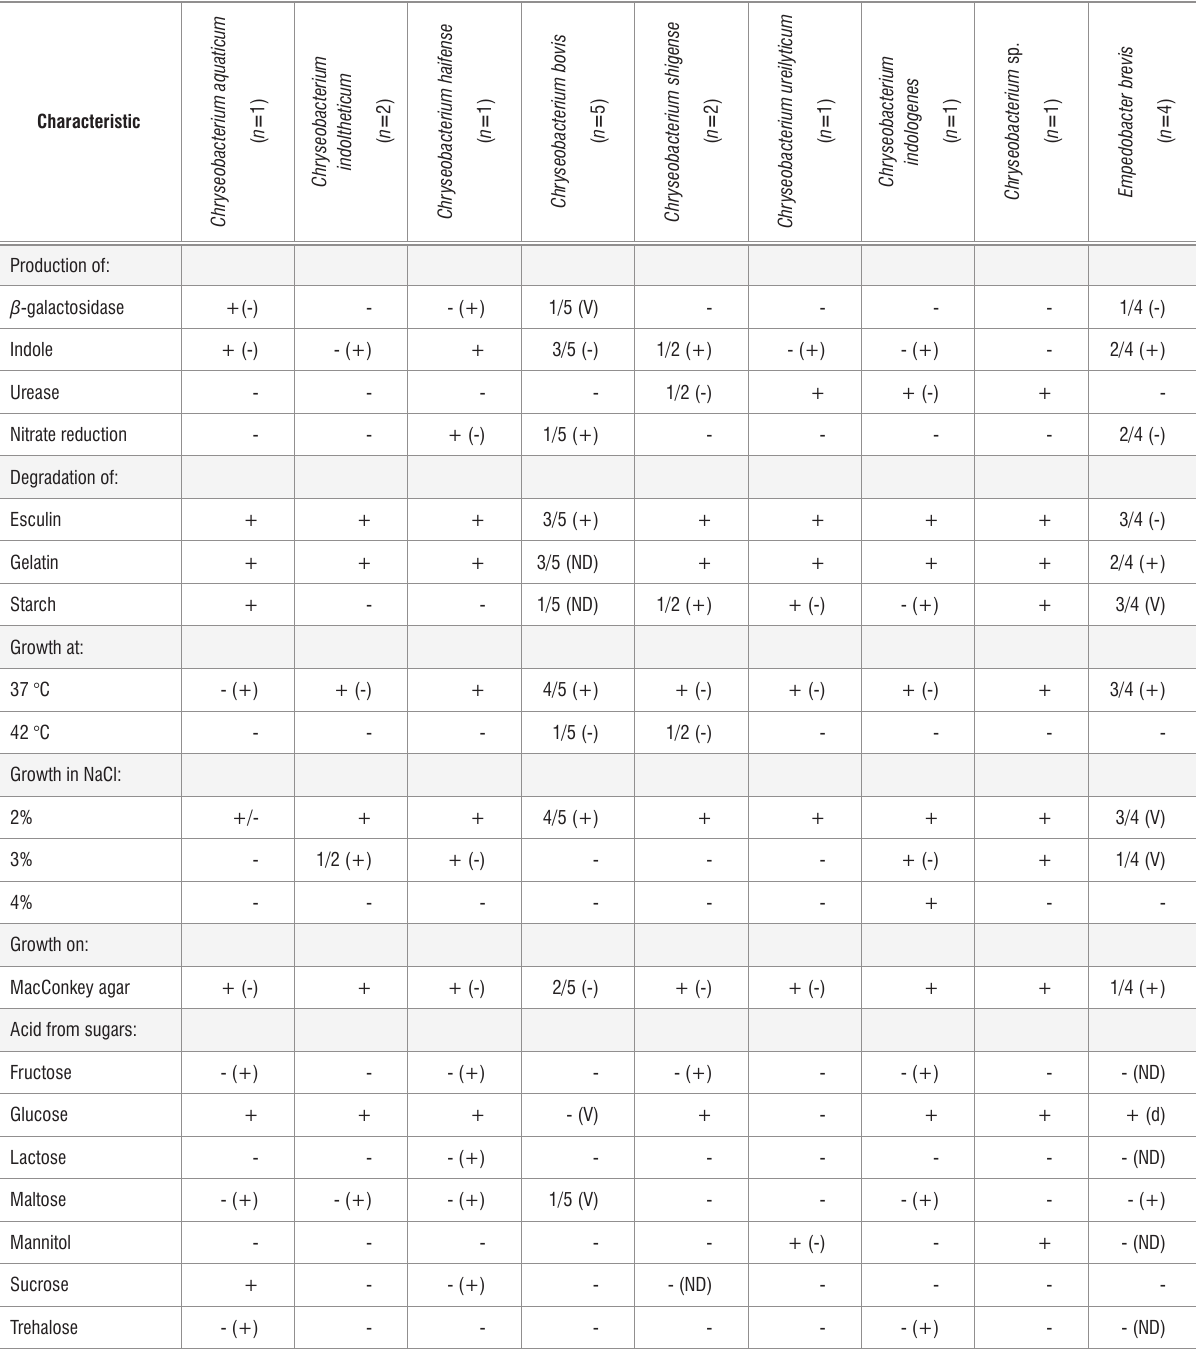
Differential phenotypic characteristics of the 18 dairy isolates in this study as identified using conventional methods